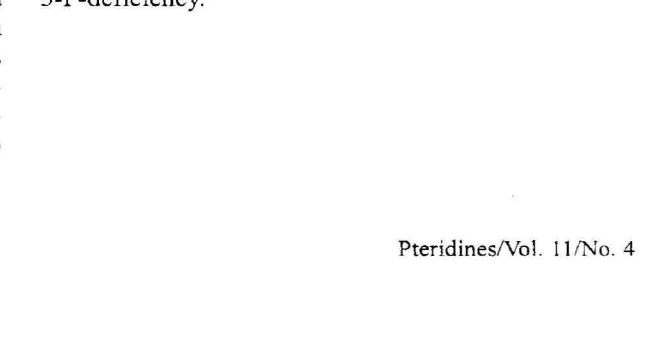
Fig.2. Content in percent (mean ± SD) of phos phatidylcholine (lecithin), phospatidyletanolamine , sphingomyelin, phosphatidylserine and phosphatidic acids in serum phospholipids of healthy individuals (open bars) as well as of cardiovascular patients with out P-5-P-deficiency (dotted bars) and of cardiovascu lar patients with P-S-P-deficiency (hatched bars); the difference is statistcally significant (P < 0.05). The analysis of fatty acid composition of whole phospholipid and lecithin (Fig. 3) indicated an increased saturated (palmitic acid) and a decreased unsaturated (oleic and linoleic acid) fatty acid content of whole phospholipid and lecithin in cardiovascular patients with P-5-P-deficiency. Similar changes in fatty acid content of phospholipids were found in ery throcyte membranes of cardiovascular patients with P